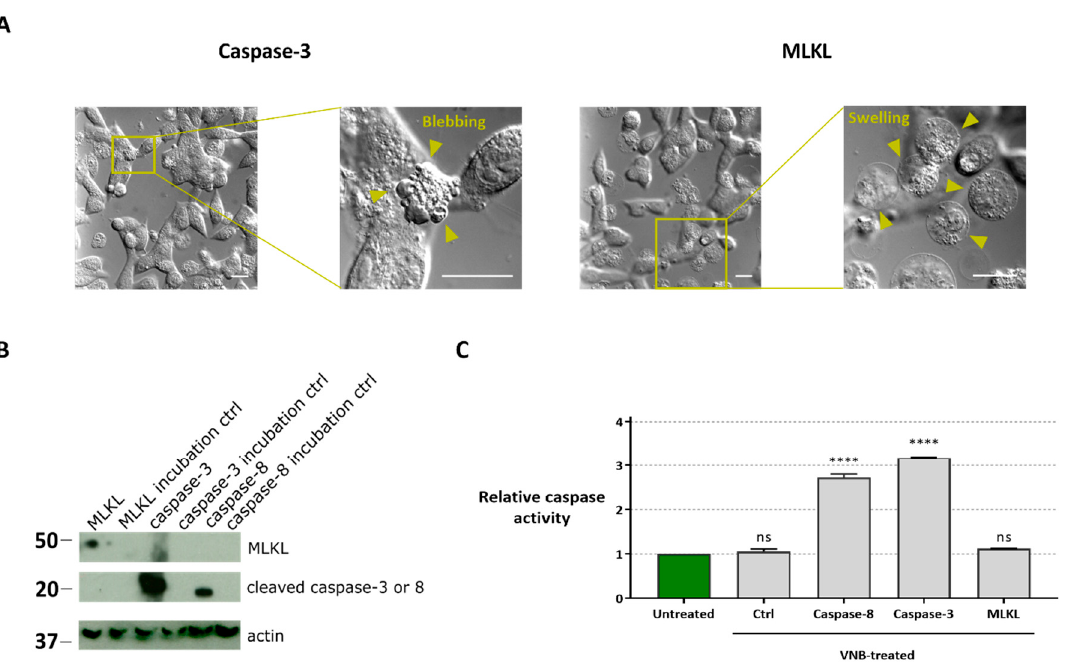
Figure 5. Characterization of cell death modality after protein transfection. ( A ) Di ff erential interference contrast light microscopy visualization of the cell morphology 30 min after caspase-3 and MLKL protein transduction (scale bars = 20 µ m). ( B ) Western blot analysis of caspase-3, caspase-8 and MLKL protein in B16 cell lysates with or without (ctrl) VNB photoporation. MLKL, caspase-3, caspase-8